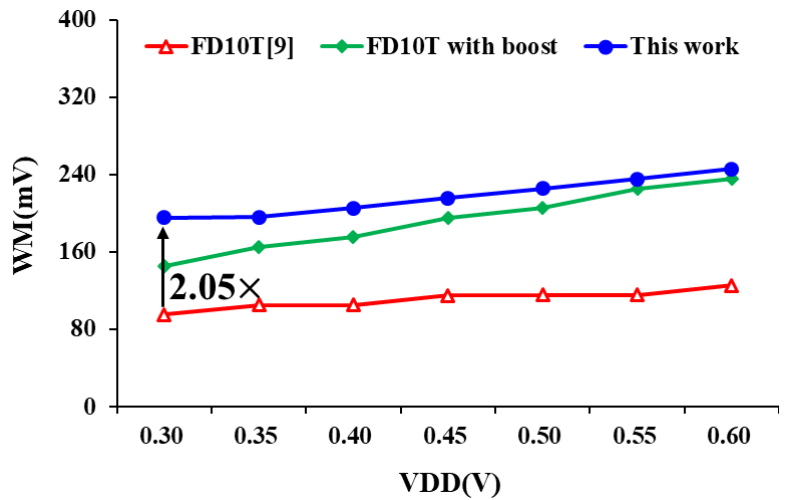
Figure 11. Write margin of bit-cell at different voltages.